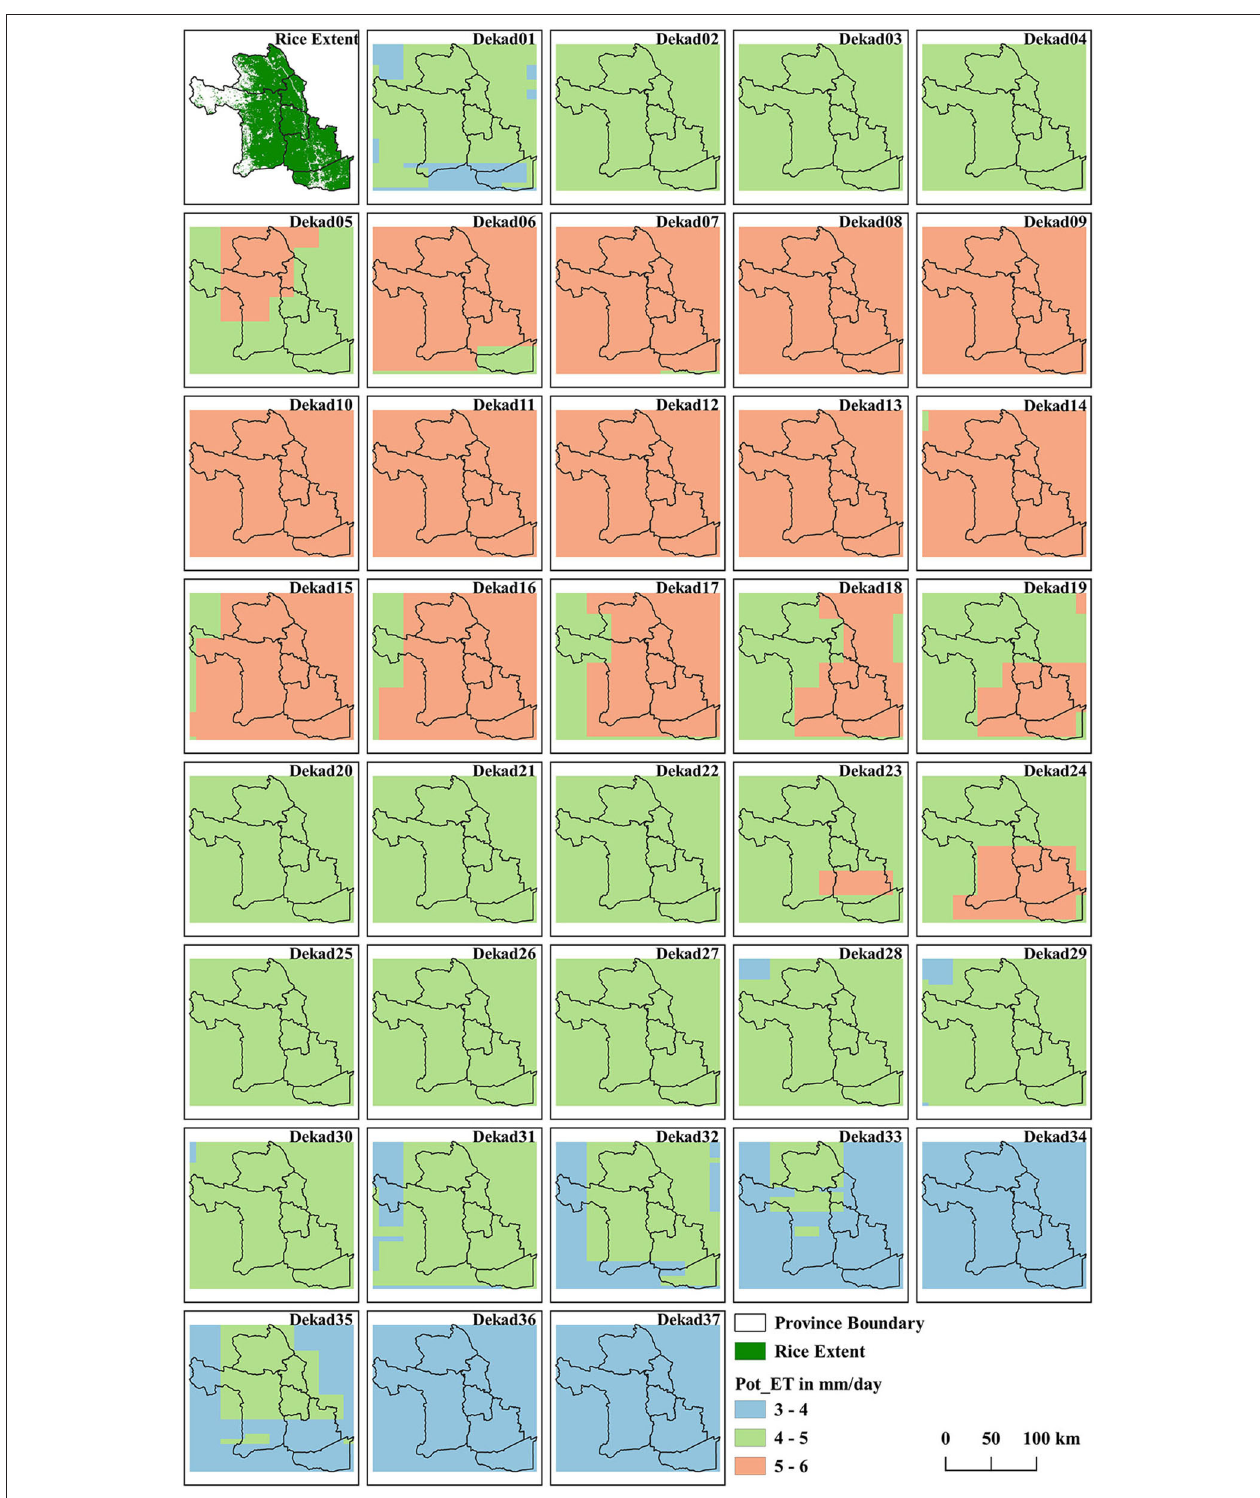
FIGURE 4 | Eleven-years mean potential evapotranspiration (Pot_ET) in the target area per dekad.